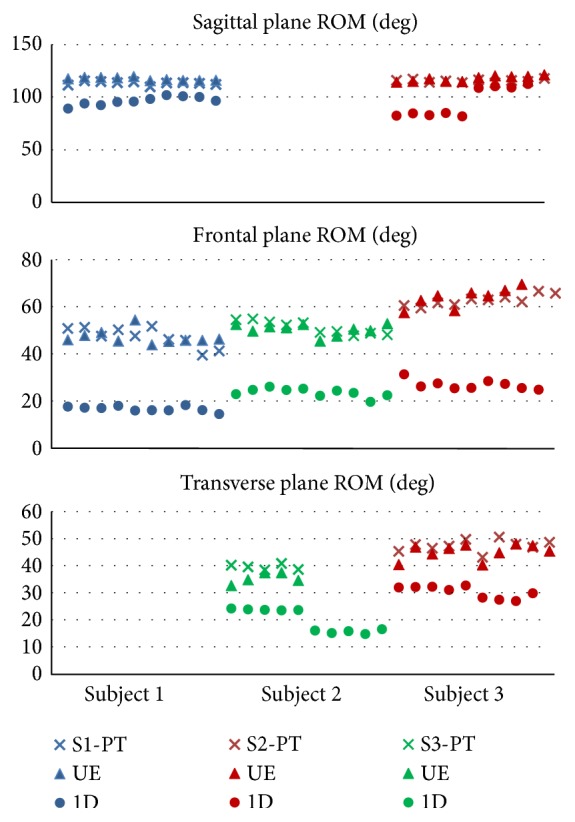
Maximum ROM measurements for all subjects in all equipment states. Subjects are denoted by color: subject 1 (S1) in blue, S2 in green, and S3 in red. The different equipment states are distinguished by marker symbol: crosses for the PT state, triangles for the UE state, and circles for the 1D state. The gaps in the graph are the result of data rejection due to marker disappearance and unauthorized movements of the torso during the testing procedure.